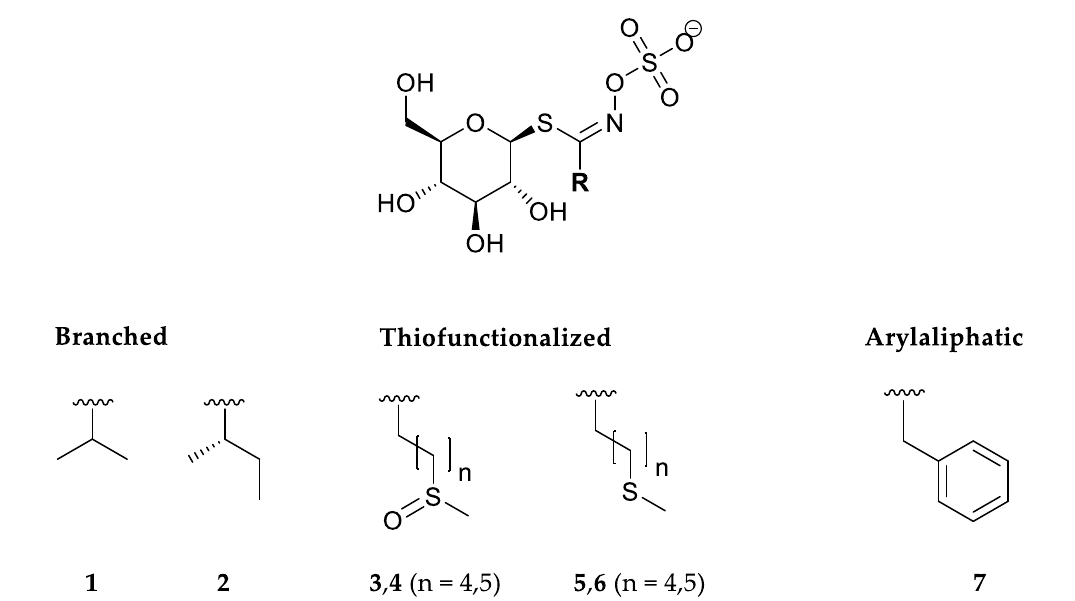
Figure 2. Structures of the glucosinolates identified in Lunaria annua seeds. 1 – Glucoputranjivin, 2 – glucocochlearin, 3 – glucoalyssin, 4 – glucohesperin, 5 – glucoberteroin, 6 – glucolesquerellin, 7 – glucotropaeolin.